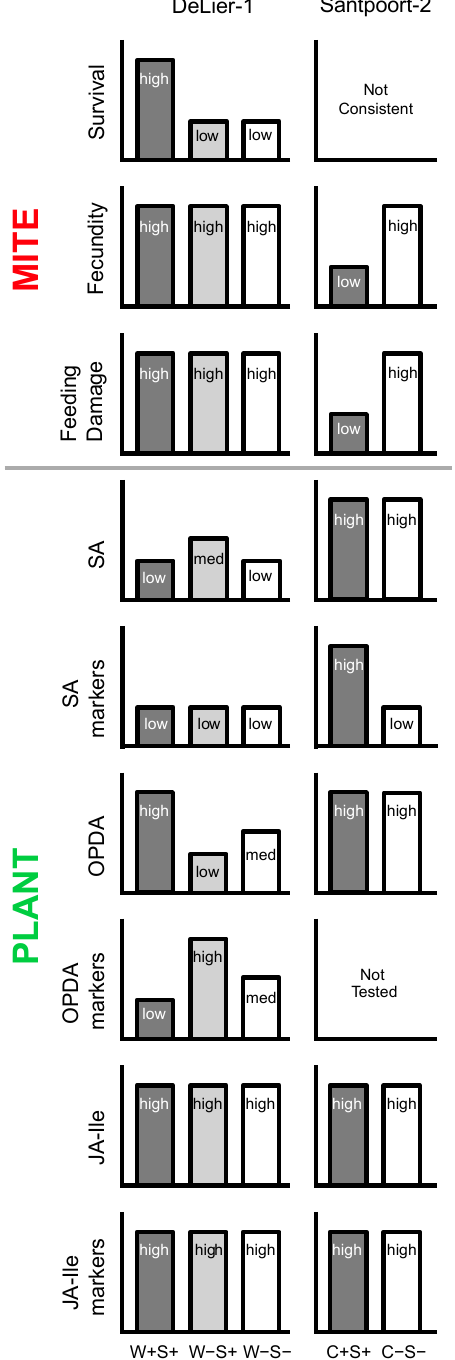
Figure 8. Schematic and simplified overview of the most important findings of this study. Adult female spider mites ( T. urticae ) from the DeLier-1 strain and the Santpoort-2 strain were treated with antibiotics to remove their associated bacteria Wolbachia sp. (W), Spiroplasma sp. (S) and/or Cardinium (C), after which the indicated mite and plant (tomato; S. lycopersicum ) parameters were assayed. For a more detailed description we refer to the Results and Discussion sections. med: intermediate; +: bacteria present; − : bacteria absent.